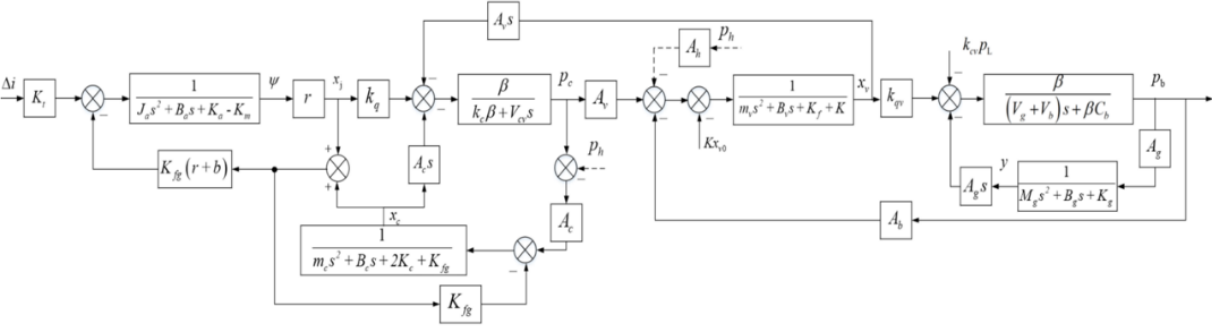
Figure 23. Block diagram of PSVS.